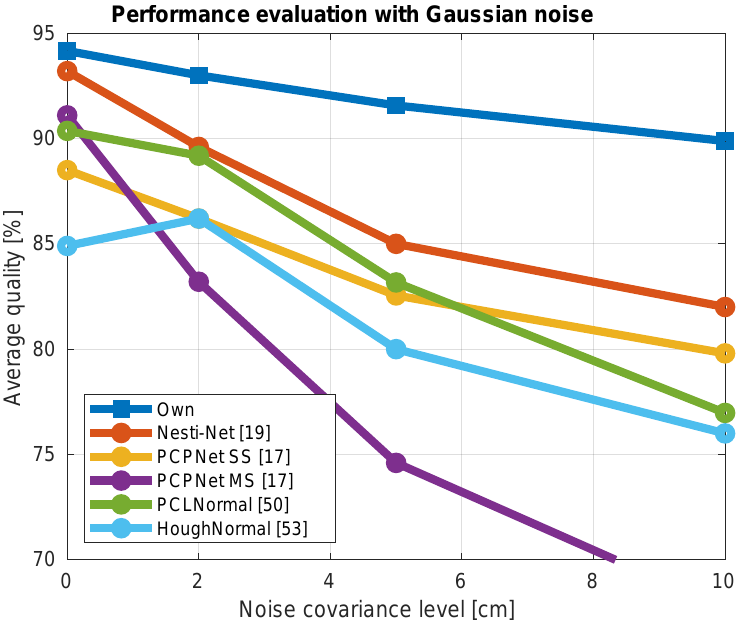
Figure 7. The effect of noisy data for different normal estimation methods.